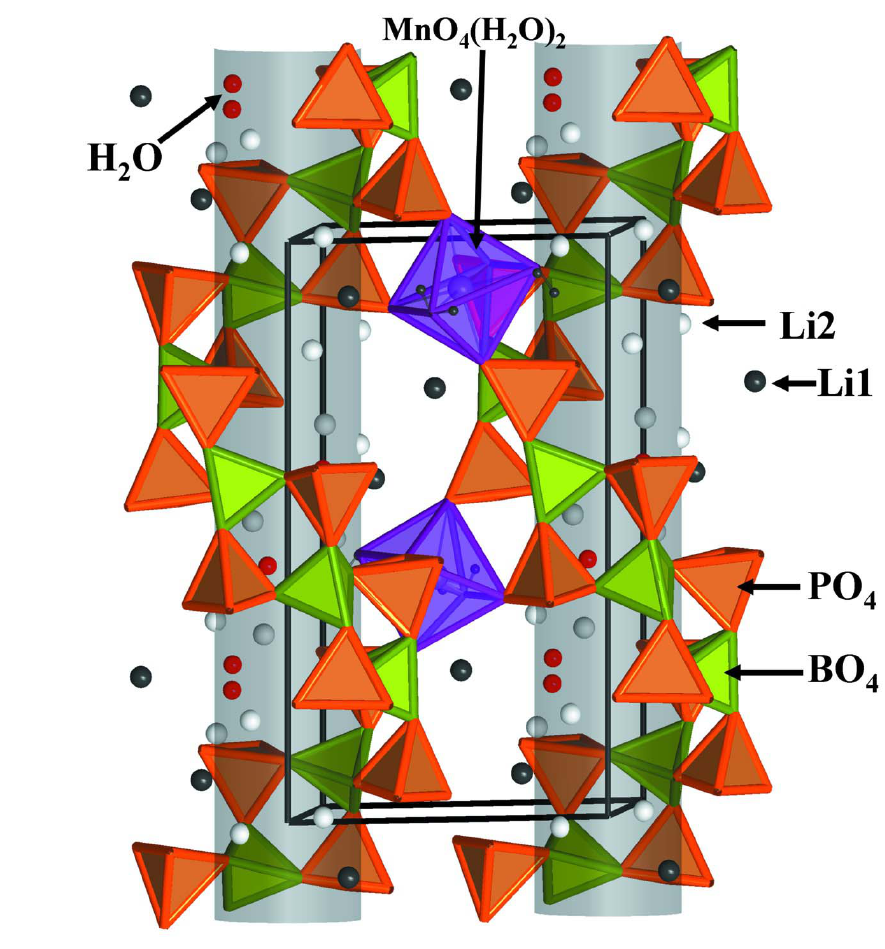
Figure 1 Linkage of borophosphate helices in LiMn(H PO , orange tetrahedra; MnO 4